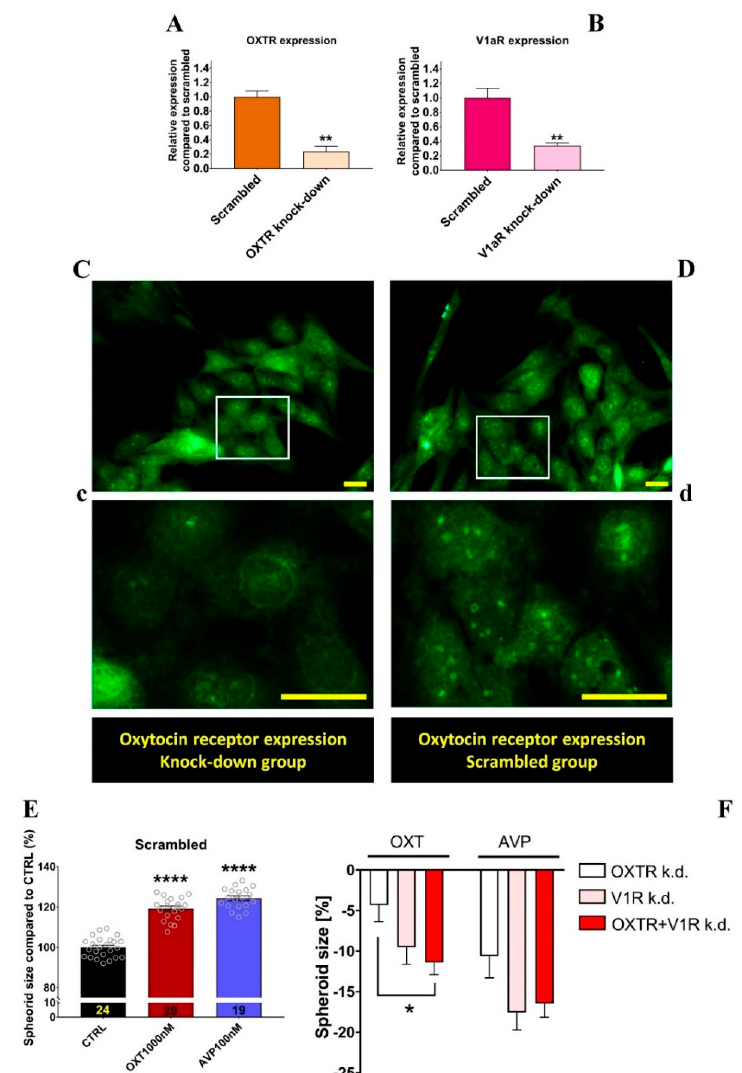
Figure 6. ( A ) Relative mRNA expression levels of the OXTR in H32 cells transfected with